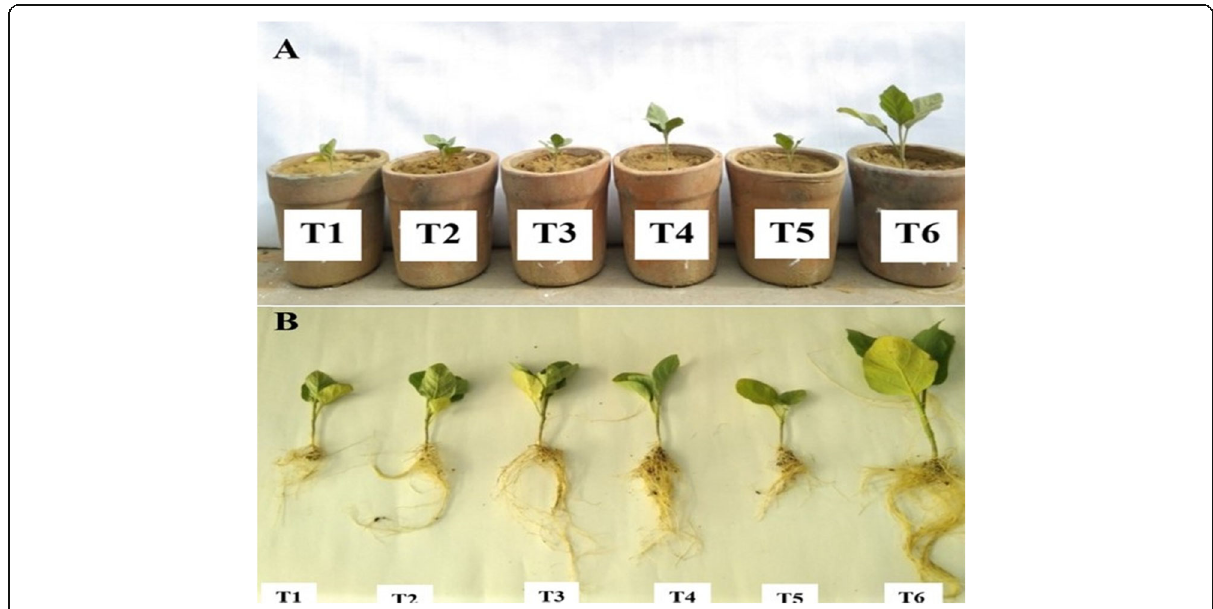
Fig. 2 Comparative plant growth in Bacillus aryabhattai KMT-4 treatment (T6) with T1, T2, T3, T4, and T5 ( a in pots, b after harvest) during the pot house experiment on brinjal ( Solanum melongena L.) crop